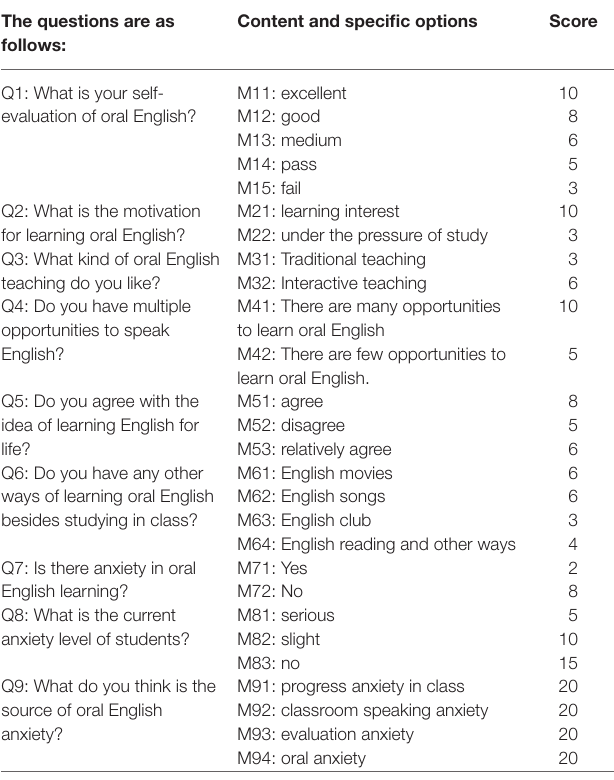
TABLE 1 | Key question design of the